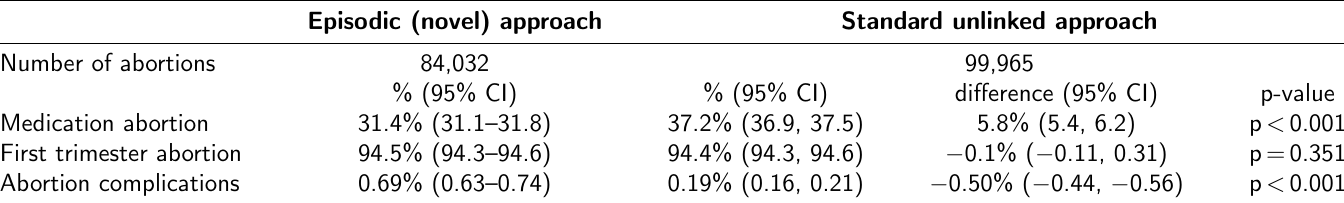
Table 3: Impact of using episodic vs. standard unlinked approach (Principle 3) to define abortion cohorts on the number and characteristics of abortions identified